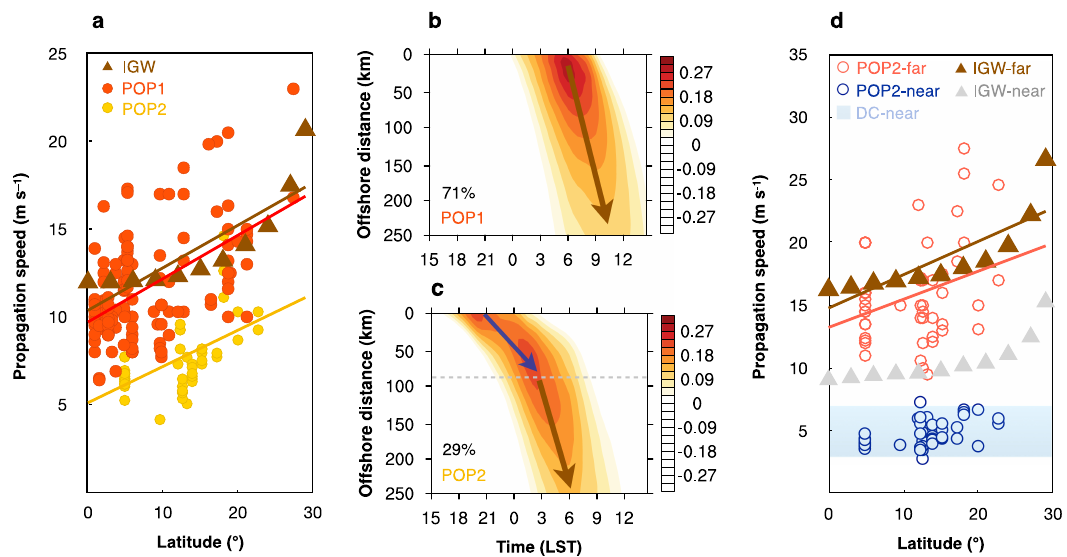
Fig. 4 | Mechanisms of pronounced offshore propagation (POP). a The propa- gationspeedofthepost-midnightPOPsamples(POP1,reddots),pre-midnightPOP samples (POP2, yellow dots), and analytical solutions of inertia – gravity wave forced by the terrain/land – sea thermal contrast (IGW, brown triangles) with the latitude. The least square fi t lines between the propagation speed and latitude for POP1 ( r =0.53, P <0.001), POP2 ( r =0.56, P <0.001) and IGWs ( r =0.85, P <0.005) are indicated by yellow, red and brown lines, respectively. b – c Composite distance – time Hovmöller diagrams of the hourly precipitation deviation (shaded, mm) for POP1 and POP2. The brown and blue arrows indicate the diurnal rainfall propagation driven by IGWs and density currents (DCs), respectively. The propa- gation speed transition for POP2 is indicated by the grey dashed line. d The far-